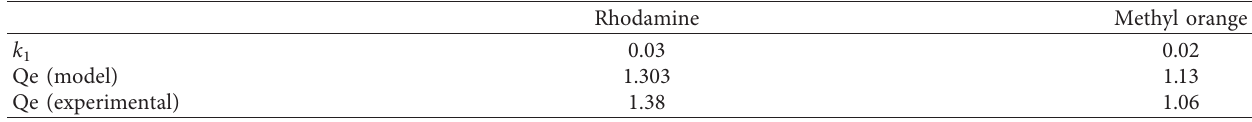
Table 6: A summary of pseudo-first-order degradation process model parameters.